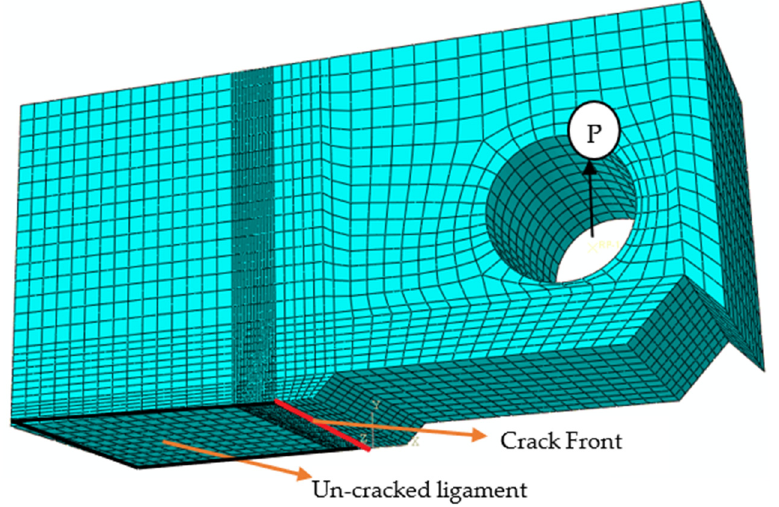
Figure 3. C(T) Meshed Model with Boundary conditions.